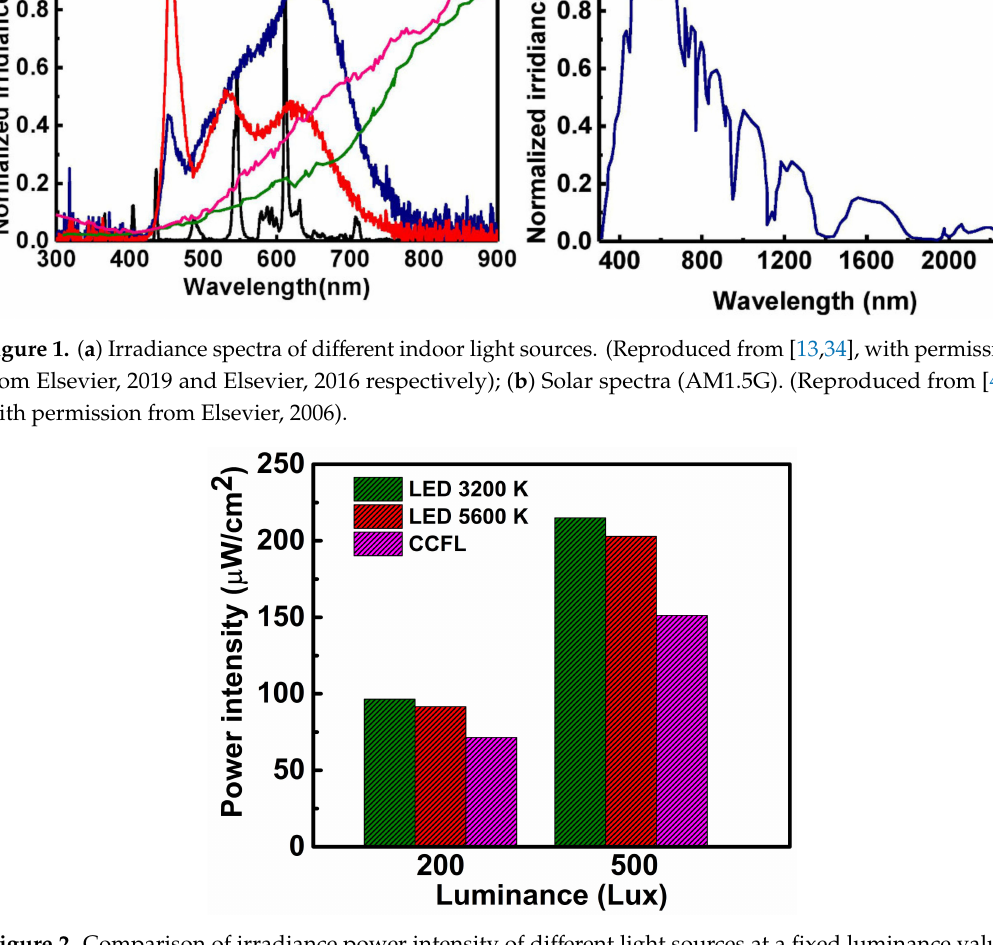
Figure 2. Comparison of irradiance power intensity of di ff erent light sources at a fixed luminance